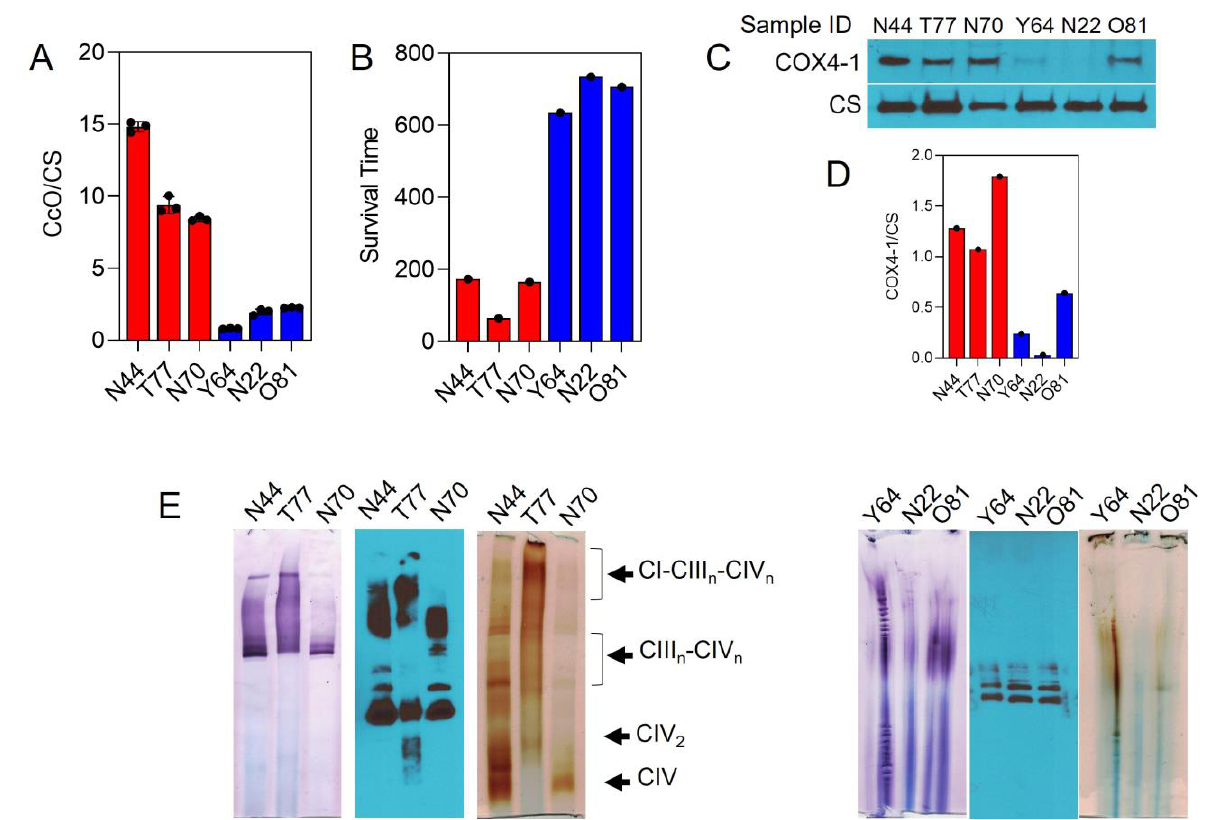
FIGURE 9: CcO is incorporated into mitochondrial SCs in patient biopsy samples. (A) CcO activity in human GBM tumors. Data are present- ed as the mean ± SEM (n=3). (B) Survival time of patients. (C) Representative Western blot showing the expression of COX4-1 in GBM tu- mors. Citrate synthase (CS) was probed as a loading control. (D) Densitometric analysis of Western blot in C. (E) Digitonin-solubilized mito- chondria from GBM tumors were subjected to BN-PAGE followed by complex I and IV IGA assays and complex III Western blot